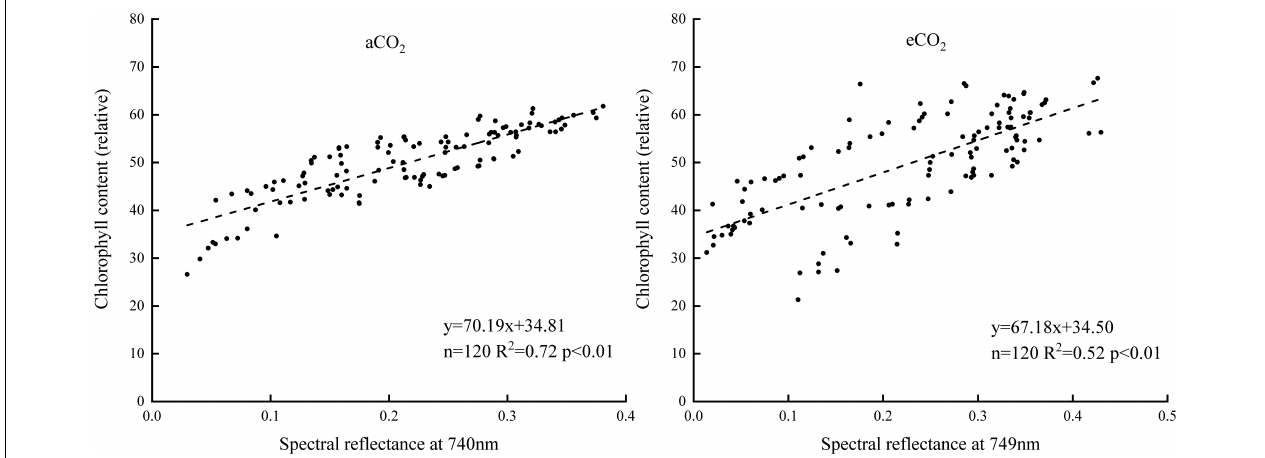
FIGURE 5 | The relationship between the chlorophyll content and the sensitive bands position of the spectral reflectance.